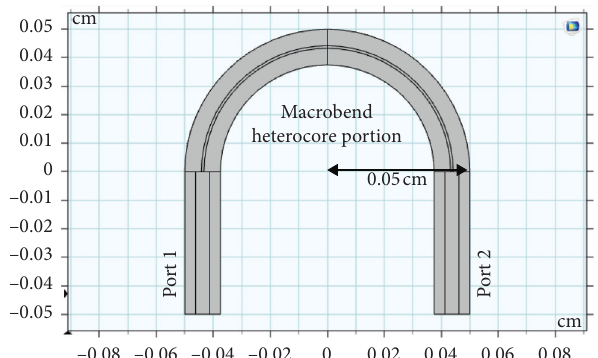
Figure 1: The structure of optical fiber based on bend